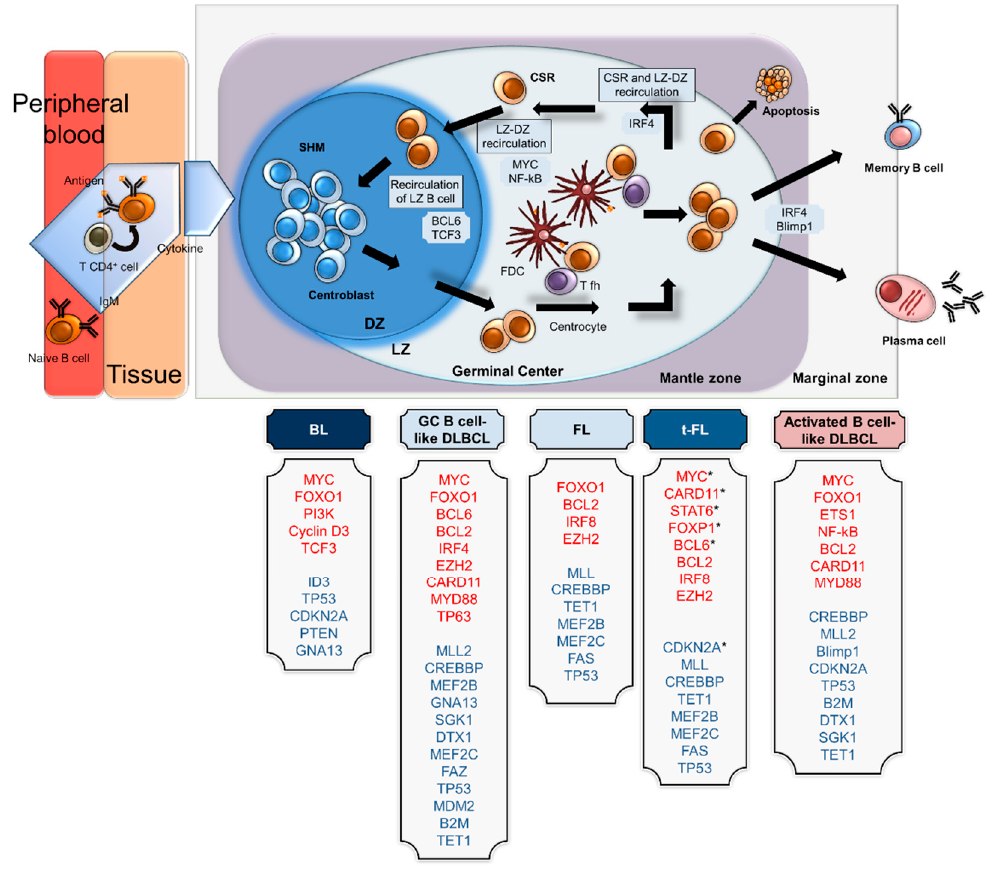
Figure 3. Cellular origin and expression profiles of transcriptional factors in different B-cell lymphomas. Schematic representation of the cellular origins of different subtypes of B-cell lymphomas: Burkitt lymphoma (BL) is reported to originate from centroblasts from the dark zone (DZ); germinal centre B cell-like (GCB)-diffuse large B cell lymphoma (DLBL) and follicular lymphoma (FL) have features resembling cells from the light zone (LZ); and activated B cell-like (ABC)- DLBCL is related to B-cell terminal differentiation before the plasma cell stage. The names of overexpressed genes are indicated in red, and the names of downregulated genes are indicated in blue. * genes reported to be deregulated in t-FL.